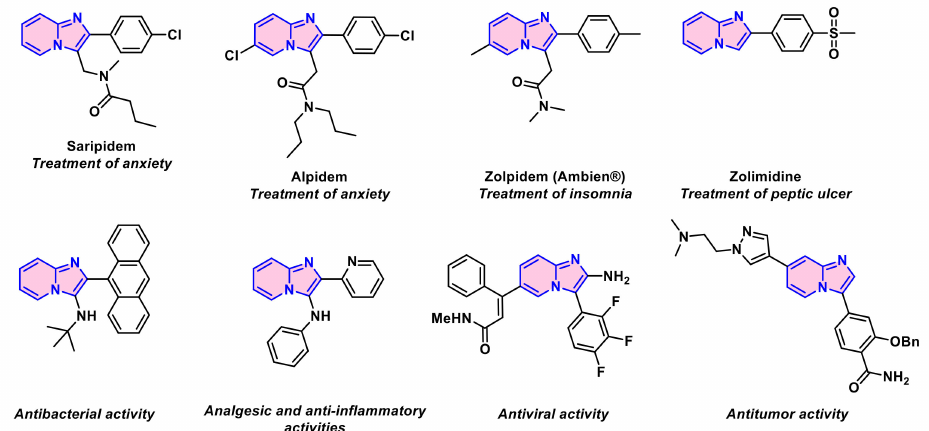
Figure 1. Examples of drugs and biologically relevant compounds displaying an imidazo[1,2- a ]1,2- a ]pyridine